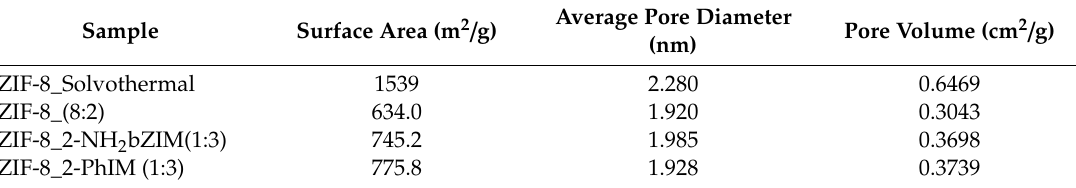
Table 1. Surface area, pore diameter and pore volume of synthesized